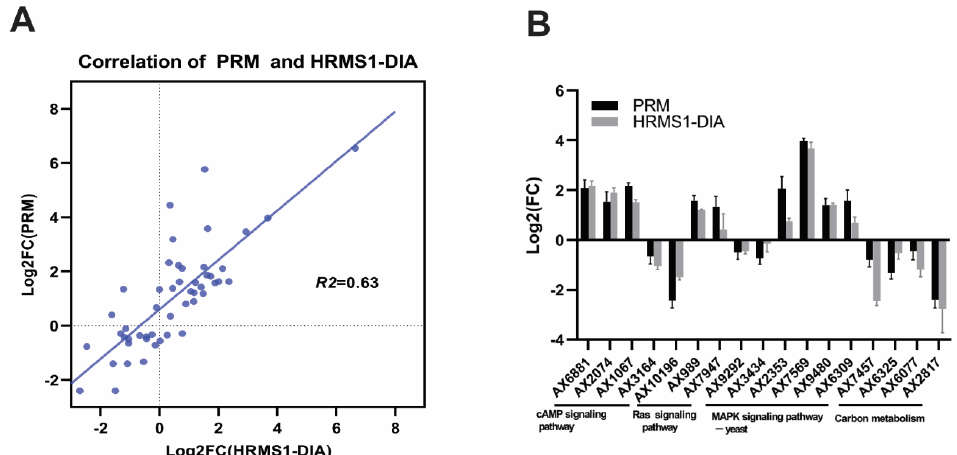
Figure 4. Parallel reaction monitoring (PRM) validation of high-resolution MS1-based quantitative data-independent acquisition (HRMS1-DIA) proteomics quantification. ( A ) Correlation between PRM quantification and HRMS1-DIA quantification of all 50 selected proteins. ( B ) The comparison of proteins related to significantly enriched KEGG pathways between PRM and HRMS1-DIA data.